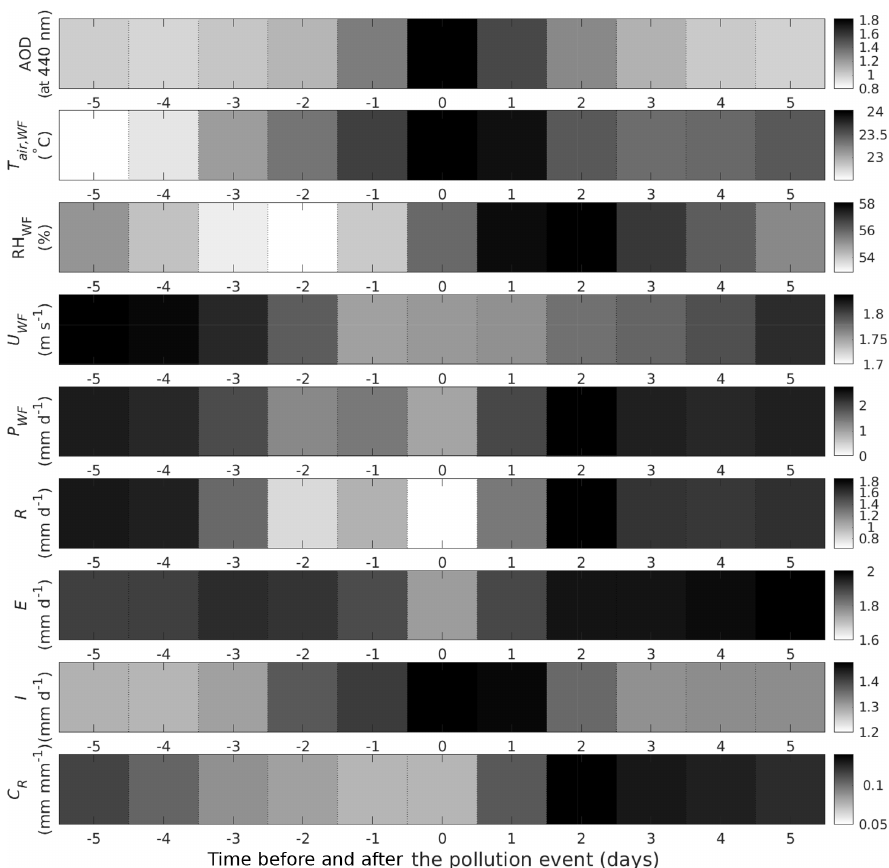
Figure 6. Average meteorological conditions of the pollution event days (AOD > 1, day 0), 5d before (days − 5 to − 1) and 5d after (days 1 to 5) in 2001–2013. Daily averages ( N = 568) of aerosol optical depth (AOD), air temperature ( T air , WF ), relative humidity (RH WF ), and wind speed ( U WF ) and daily cumulative values of observed precipitation ( P WF ) and modelled surface runoff ( R ), evapotranspiration ( E ), irrigation ( I ), and the runoff coefficient ( C R